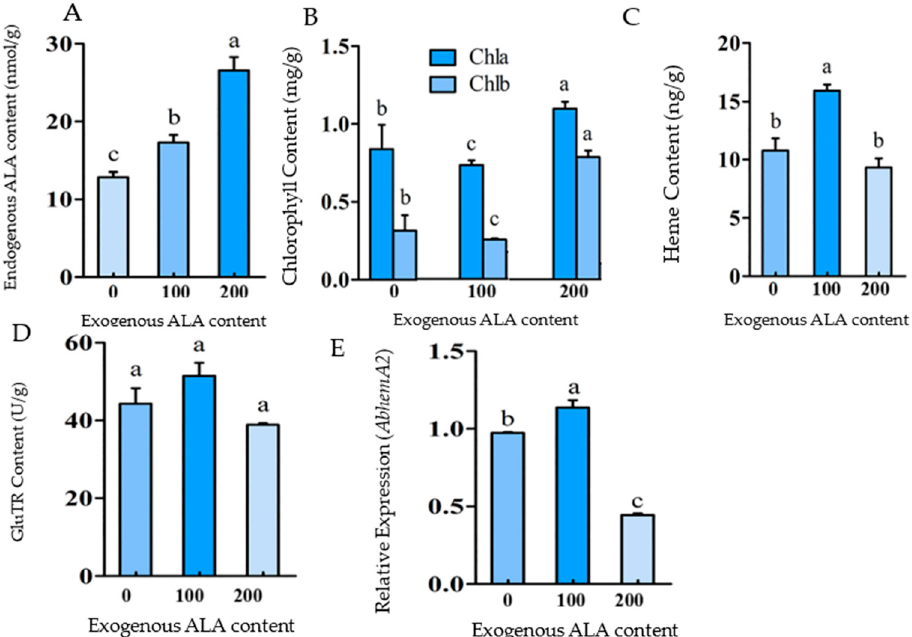
Figure 2. The effects of exogenous ALA supplementation on porphyrin metabolism. The effect of exogenous ALA supply on endogenous ALA content ( A ), The effect of exogenous ALA supply on chlorophyll content ( B ), The effect of exogenous ALA supply on heme content ( C ), The effect of exogenous ALA supply on GluTR content ( D ), and the effect of exogenous ALA supply on AbHemA2 expression ( E ). The bars represent how each bar is different from the others. The means denoted by the same letter did not differ significantly at p < 0.05.